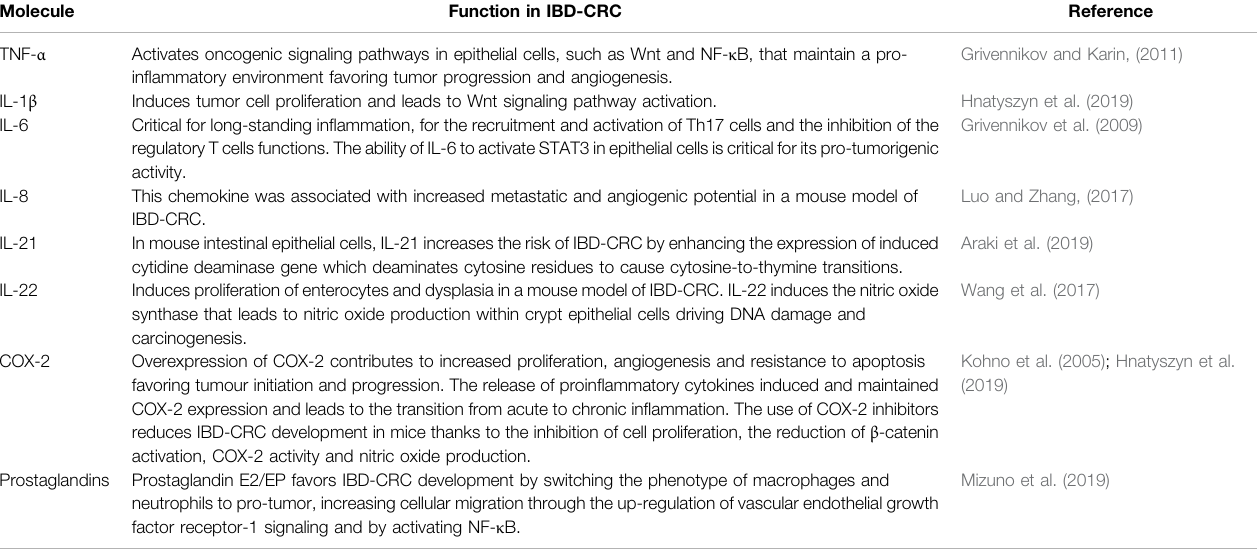
TABLE 1 | cytokines and/or pro-in fl ammatory molecules in IBD-CRC. Molecule Function in